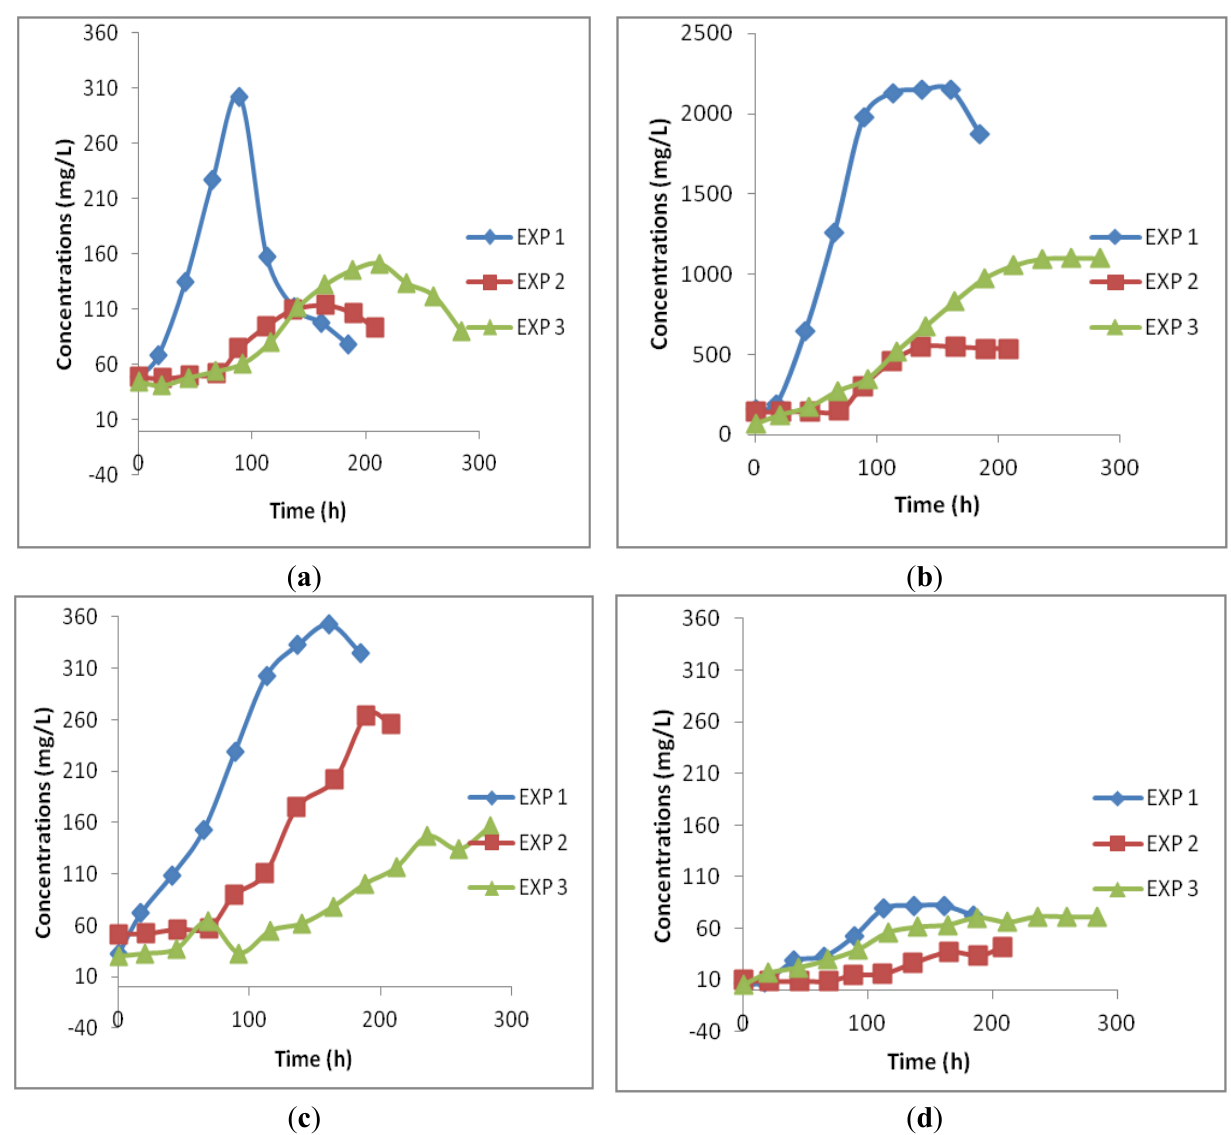
Figure 4. Cell mass ( a ) and products profiles, Acetic acid ( b ); Ethanol ( c ) and Butanediol ( d ) in three different experiments: EXP1 (pH = 5.75 and YE 1 g/L); EXP2 (pH = 4.75 and YE 1 g/L); EXP3 (pH = 5.75 and YE 0.2